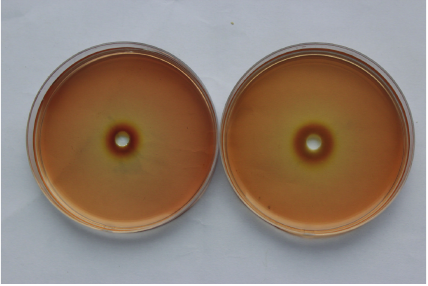
Figure 1: Diffusion of serum in 0.003 mol/L KMnO 4 .